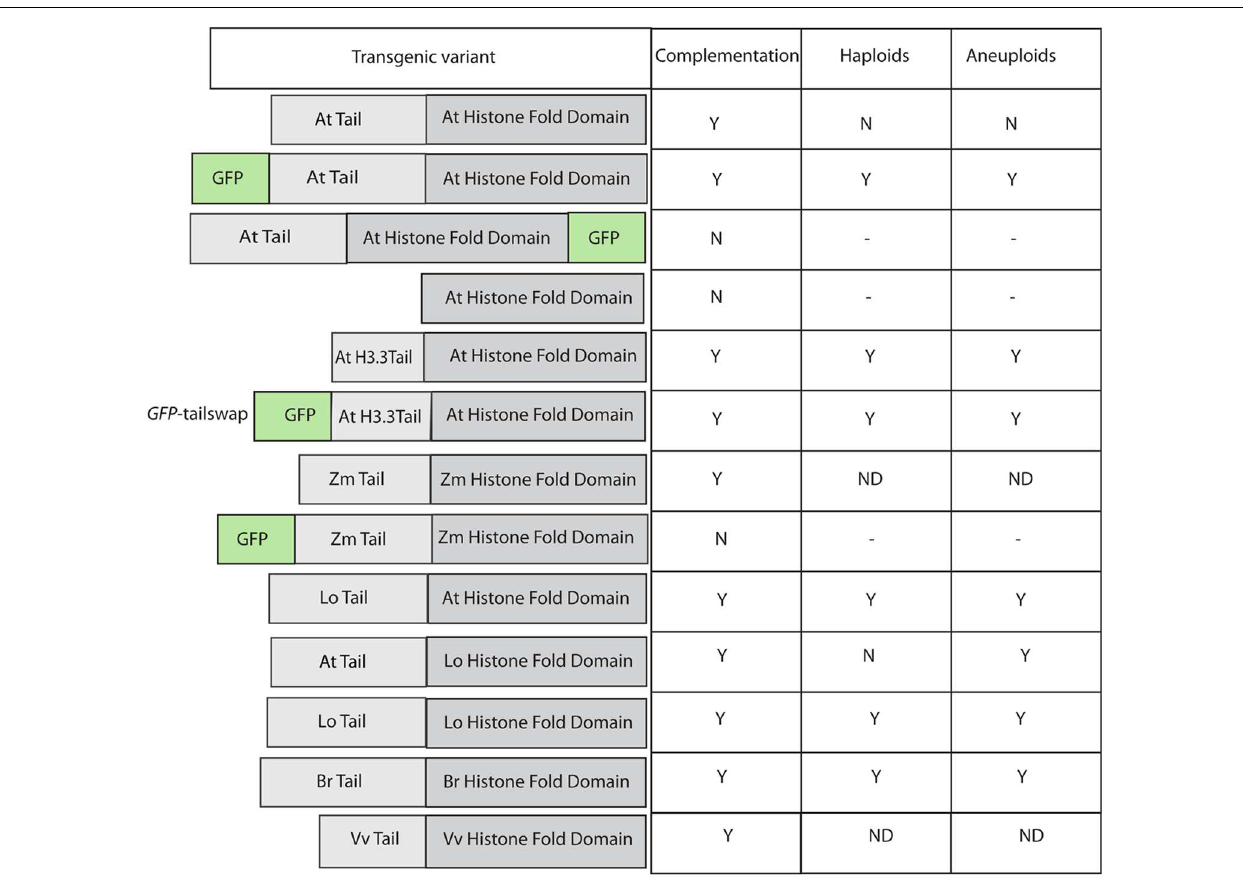
FIGURE 1 | Effect of various modifications of transgenic CENH3 variants in an Arabidopsis thaliana cenh3 null. Table on the right summarizes complementation (of viability and fertility), haploid, and aneuploid induction by these lines. GFP-tailswap is the commonly used nomenclature in published literature for this